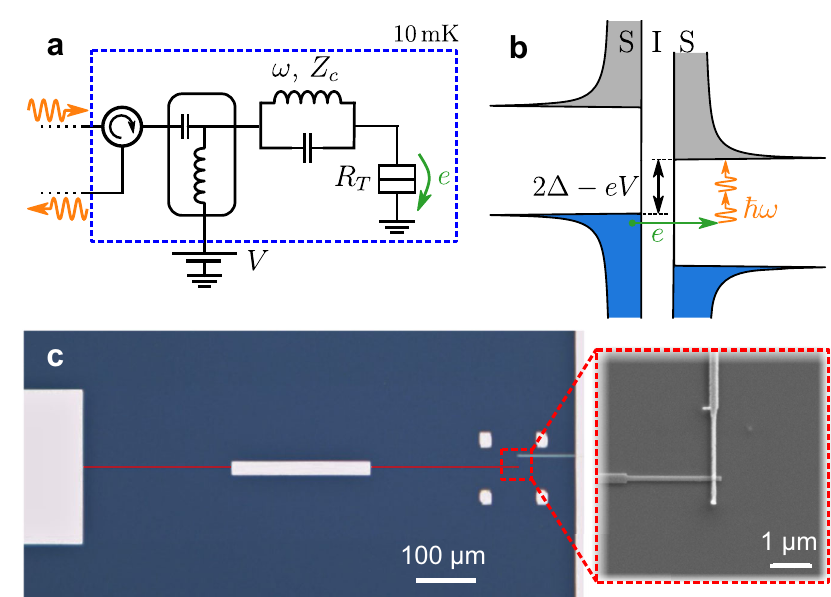
Fig. 1 | Experiment principles. a Schematic of the experimental circuit. A micro- wave mode at frequency ω ≈ 2 π ×6GHz, here represented by an LC resonator, is coupled to a superconducting tunnel junction with tunnel resistance R T . The characteristic impedance Z c of the mode is 4.5k Ω , much larger than in a conven- tionalsuperconductingresonator.Abiasteeandacirculatorareusedtodcbiasthe sample while measuringthe re fl ected microwave signal. b When the bias voltageis such that 2 Δ − eV > l ℏ ω , the tunneling of quasiparticles through the junction is allowedonlyifatleast l photons(heretwo)areabsorbedfromthemodetoprovide